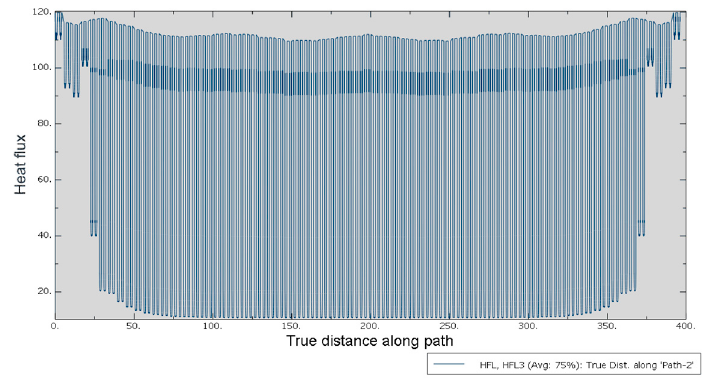
Figure 8. Heat flux (W·m − 2 ) of each node of fiber concrete.